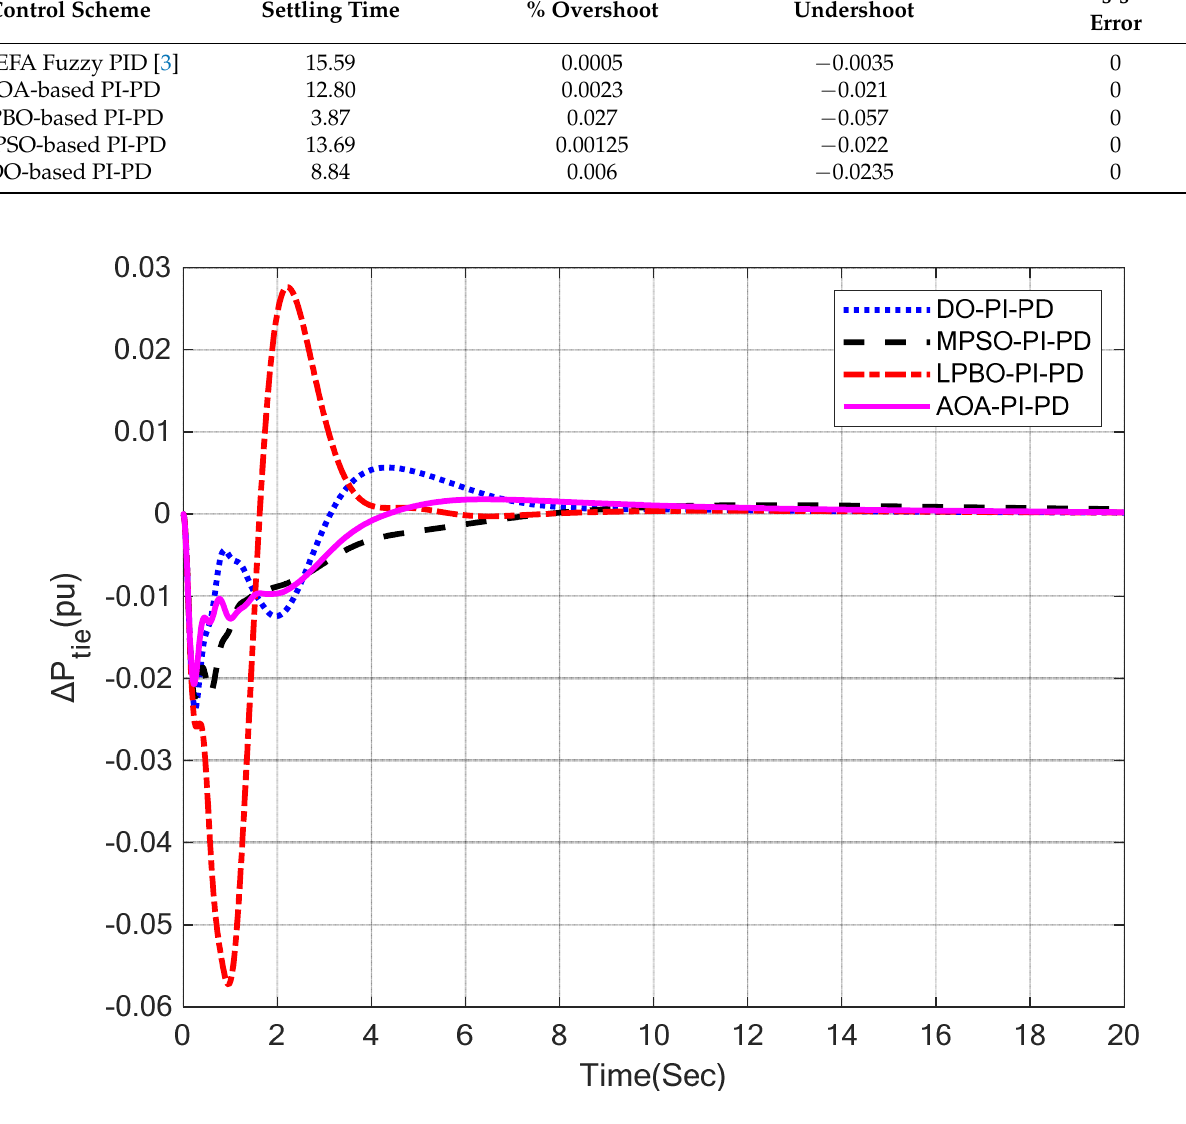
Figure 8. Tie-line power deviation responses in a two-area multi-source IPS.